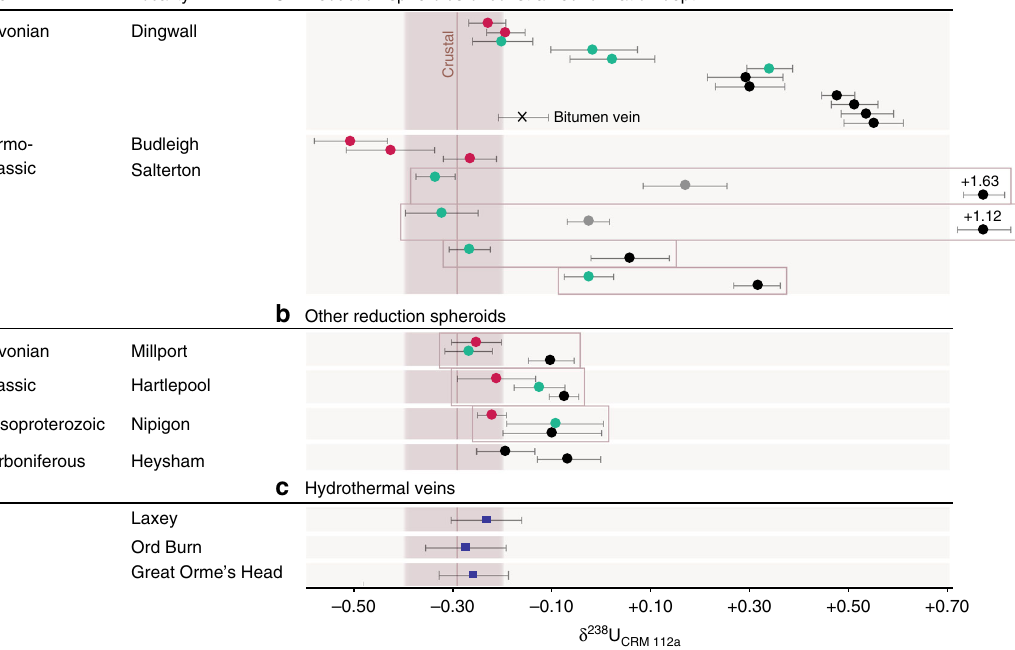
Fig. 1 Results of uranium isotope analysis. Error bars represent two standard errors. δ 238 U values are shown from reduction spheroid innermost cores (black), core margins (grey), bleached halos (cyan), and surrounding red-bed matrix (magenta). Boxes indicate physically contiguous samples. a Results from reduction spheroids of constrained formation depth. b Results from other reduction spheroids. c Results from three hydrothermal